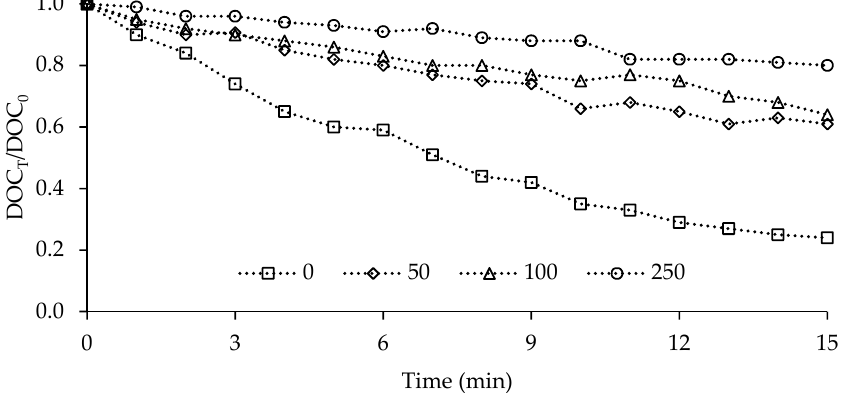
Figure 13. Effect of TBA on catalytic ozonation process ([HA] = 10 mg L − 1 , [Catalyst] = 0.050 g L − 1 , [O 3 ] = 10 mg L − 1 ).